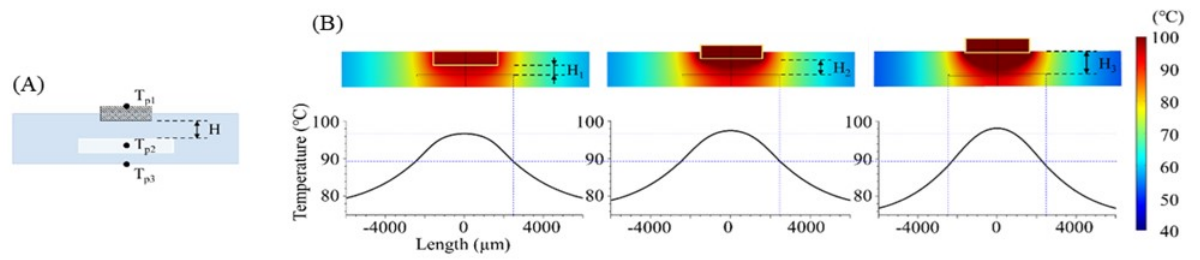
Figure 5. ( A ) Cross sectional view of the microchip (across A-A’ in Figure 1). While changing the distance between the chamber and the heater, the temperature on three points was calculated using FEM simulation (T p1 : heater, T p2 : PCR sample, T p3 : microchip surface). ( B ) Simulated